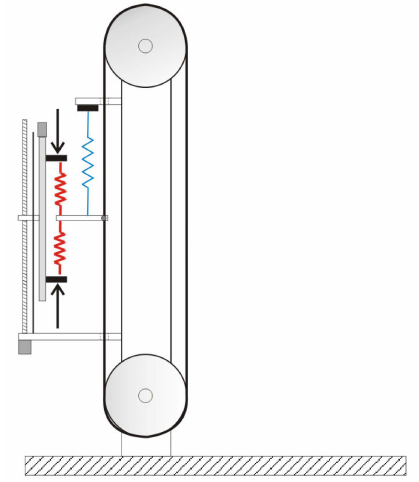
Figure 26. The BIASAT mechanism in active mode control that is used for simulation analysis.